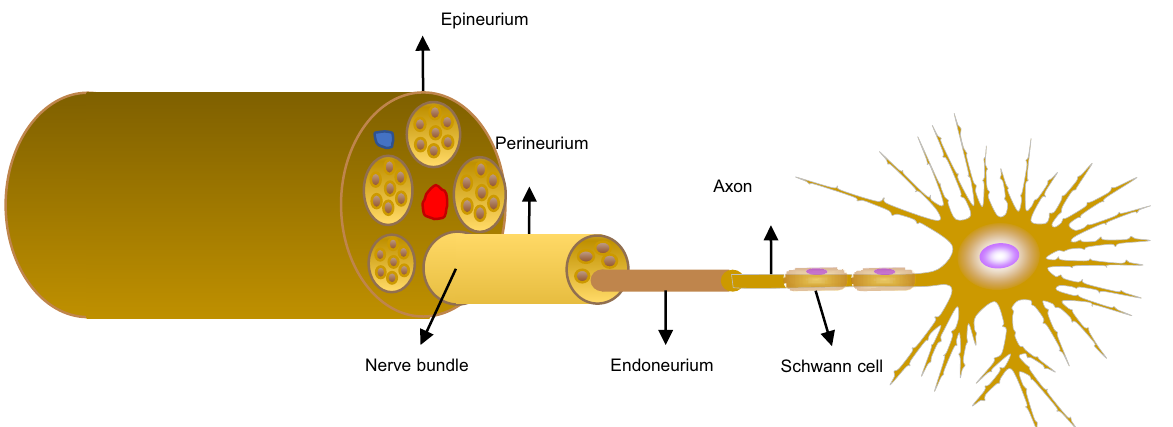
Figure 1: The anatomy of peripheral